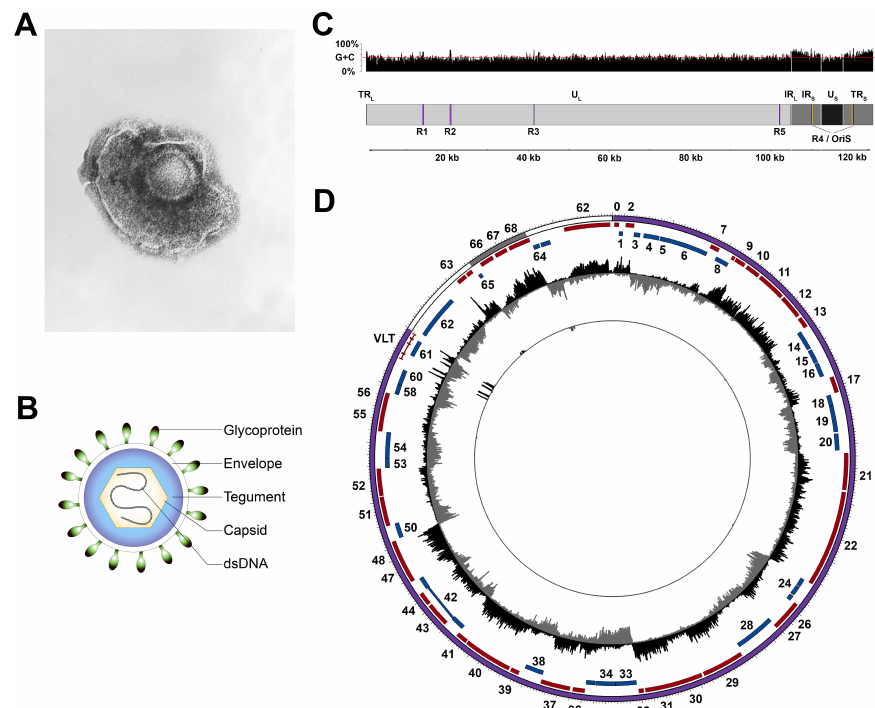
Figure 1. Structure of varicella-zoster virus (VZV) particles and genome. ( A ) Electron microscopy image of VZV (obtained from Centers for Disease Control and Prevention (CDC)/Dr Erskine Palmer; B.G. Partin. CDC Public Health Image Library). ( B ) Schematic representation of the VZV virion. ( C ) Schematic representation of the VZV genome structure and G + C content. ( D ) The VZV transcriptome profile during lytic infection of ARPE-19 cells (outer track) and latent infection of human TG (trigeminal ganglia; inner track). Note that the low frequency of VZV-infected neurons in human TG necessitates the use of targeted enrichment of VZV transcripts to detect VZV latency-associated transcript (VLT) expression [27]. Circos plot of the VZV genome (U L , TR/IR, and U S are shown as purple, white, and grey bands, respectively; sense and antisense open reading frames (ORFs) are indicated as red and blue blocks, respectively, with ORF numbers indicated where possible). Data represent strand-specific VZV-enriched mRNA-sequencing with peaks facing outwards from the center (black) indicating reads mapping to the sense strand, while peaks facing inward (grey) originate from the antisense strand. The y -axis is scaled to the maximum read depth per library in all cases. dsDNA, double-stranded DNA; U L , unique long; U S , unique short; TR, terminal repeat; IR, internal repeat; R, reiterative region; Ori, origin of